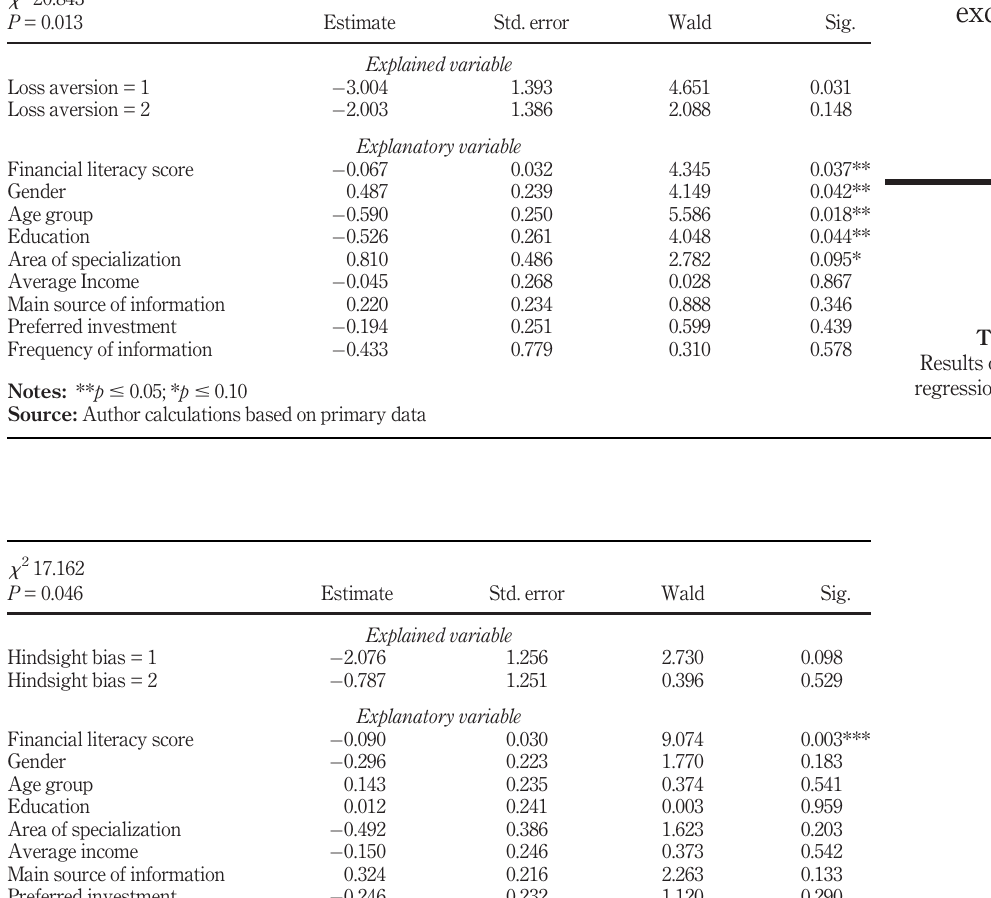
Table 12. Results of